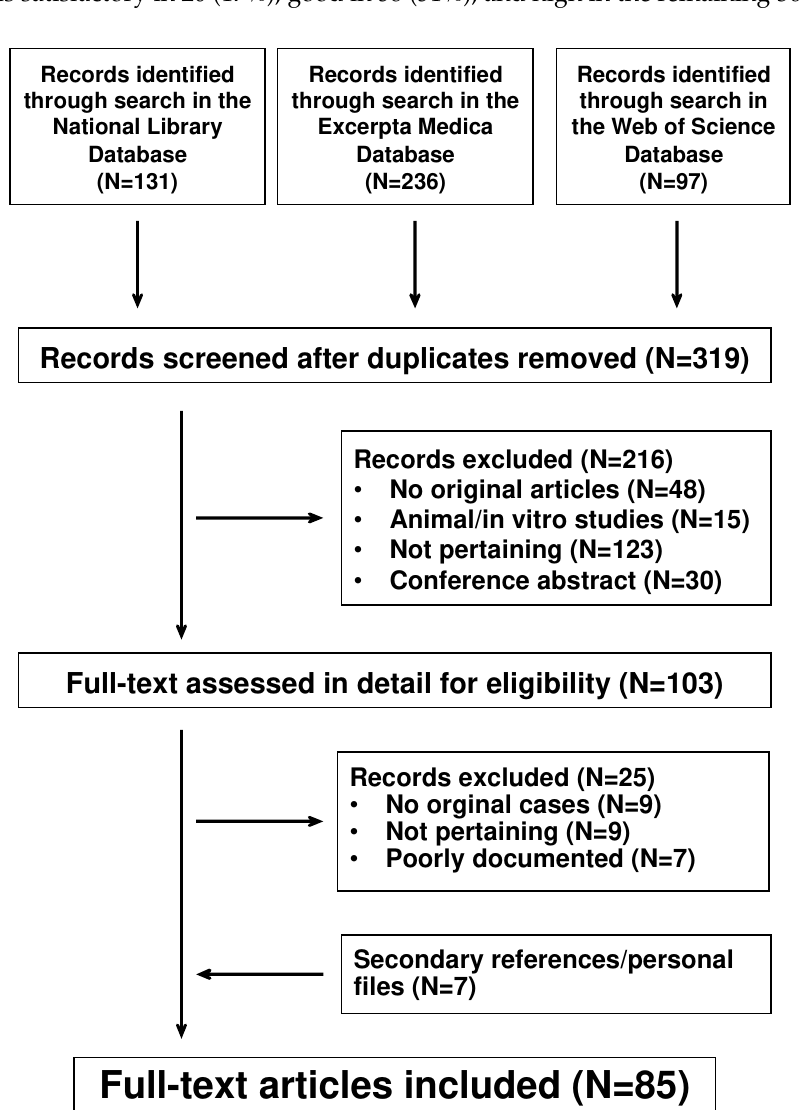
Figure 1. Involvement of external genitalia in males with Henoch–Schönlein syndrome. Flowchart of the literature search process.